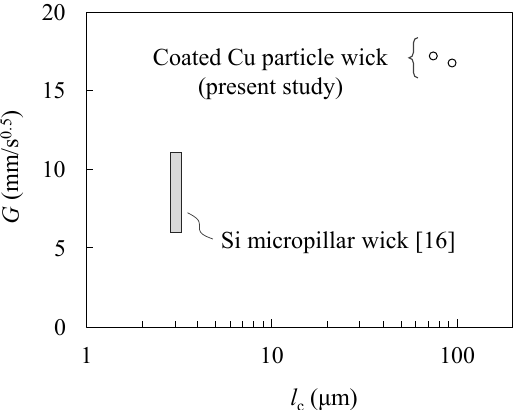
Figure 9. Comparison of the propagation coefficients: coated Cu particle wick and Si micropillar wick with experimental data [16].